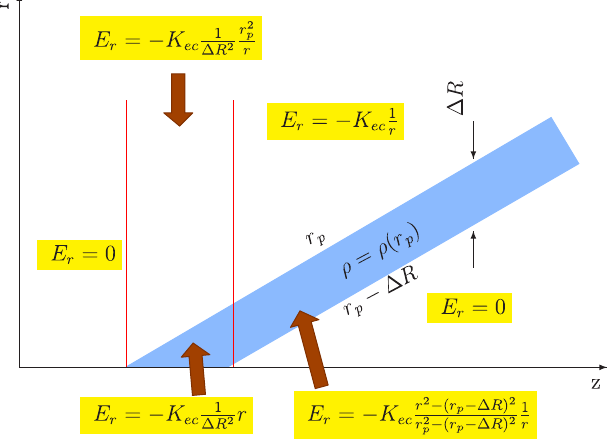
FIG. 7. (Color) The section of the axisymmetric EC stripe divides the plane ð z; r Þ into six regions, in which the analytic form of the EC-induced electric field is explicitly